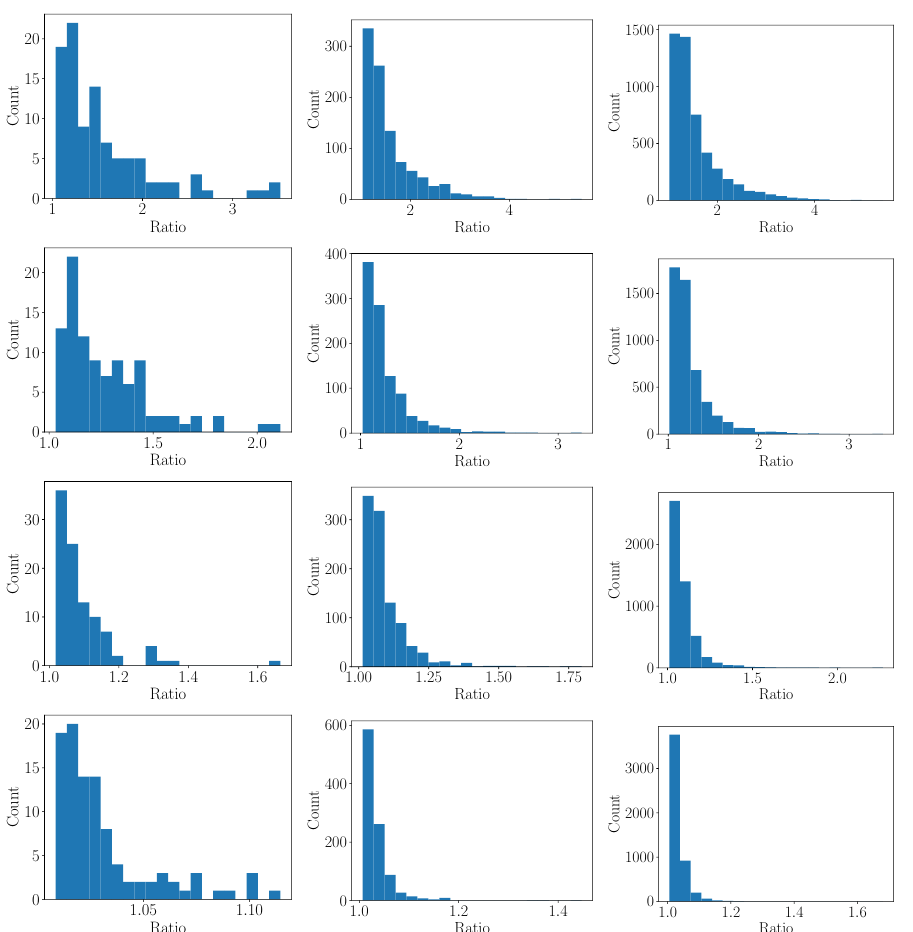
Figure 14. Histograms of maximum error ratio between interpolated and maximum value of c p . From top to bottom: 100, 200, 400, and 800 cells resolution. From left to right columns: 100, 1000, and 5000 samples. Note the change in x